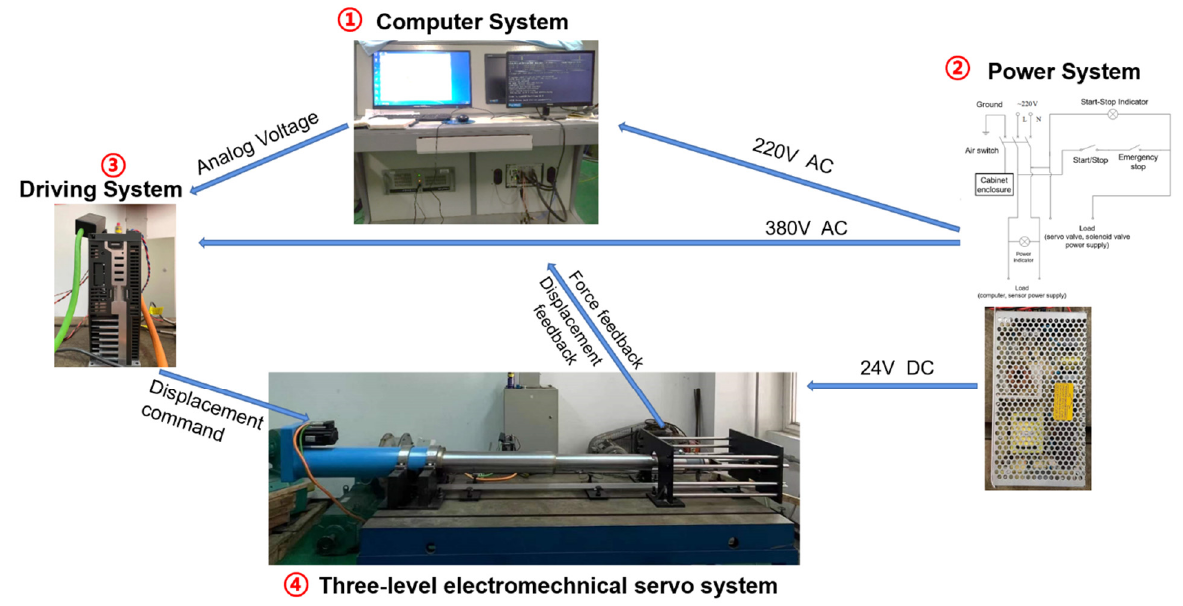
Figure 8. Schematic diagram of the composition of the test bench.